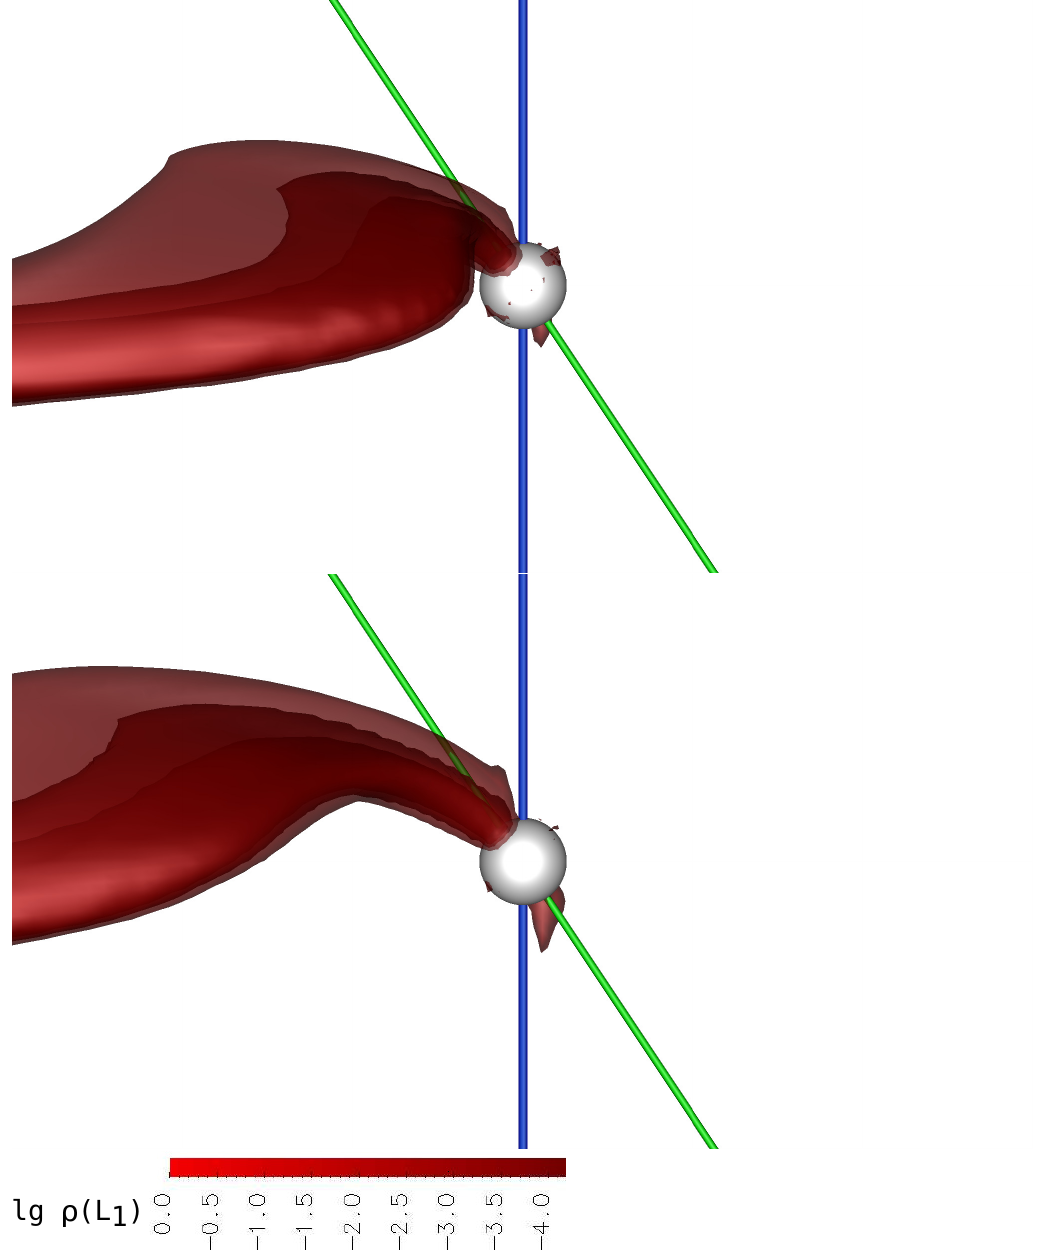
Figure 2. The result of three-dimensional numerical modeling of the flow structure in the synchronous polar for Model 1 ( upper panel) and Model 2 ( lower panel). The iso-surfaces of the decimal logarithm of the density in units of ρ ( L 1 ) are shown. The accretor is represented as a white sphere. The blue vertical line passing through the accretor coincides with its axis of rotation, and the inclined green line with its magnetic one. The binary system is shown at the point of view of an Earth observer at the orbital phase